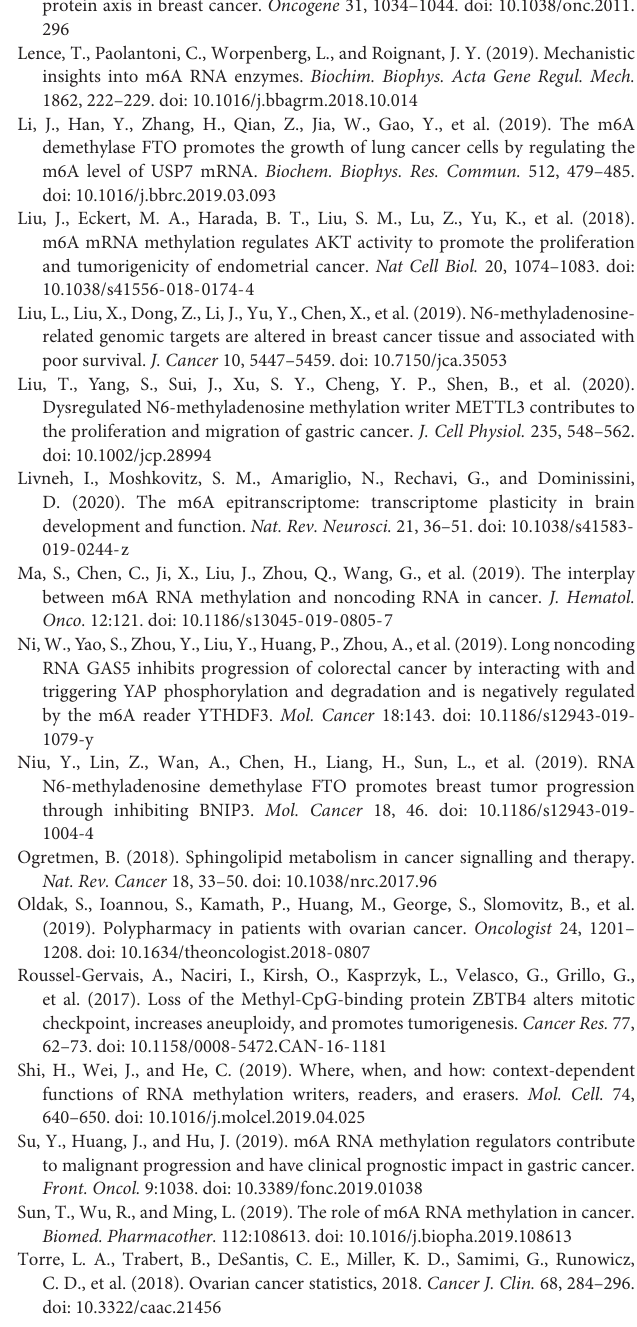
Supplementary Figure 1 | The expression levels of m 6 A methylation regulators of samples at different stages in TCGA ovarian cancer datasets (For stages: dark